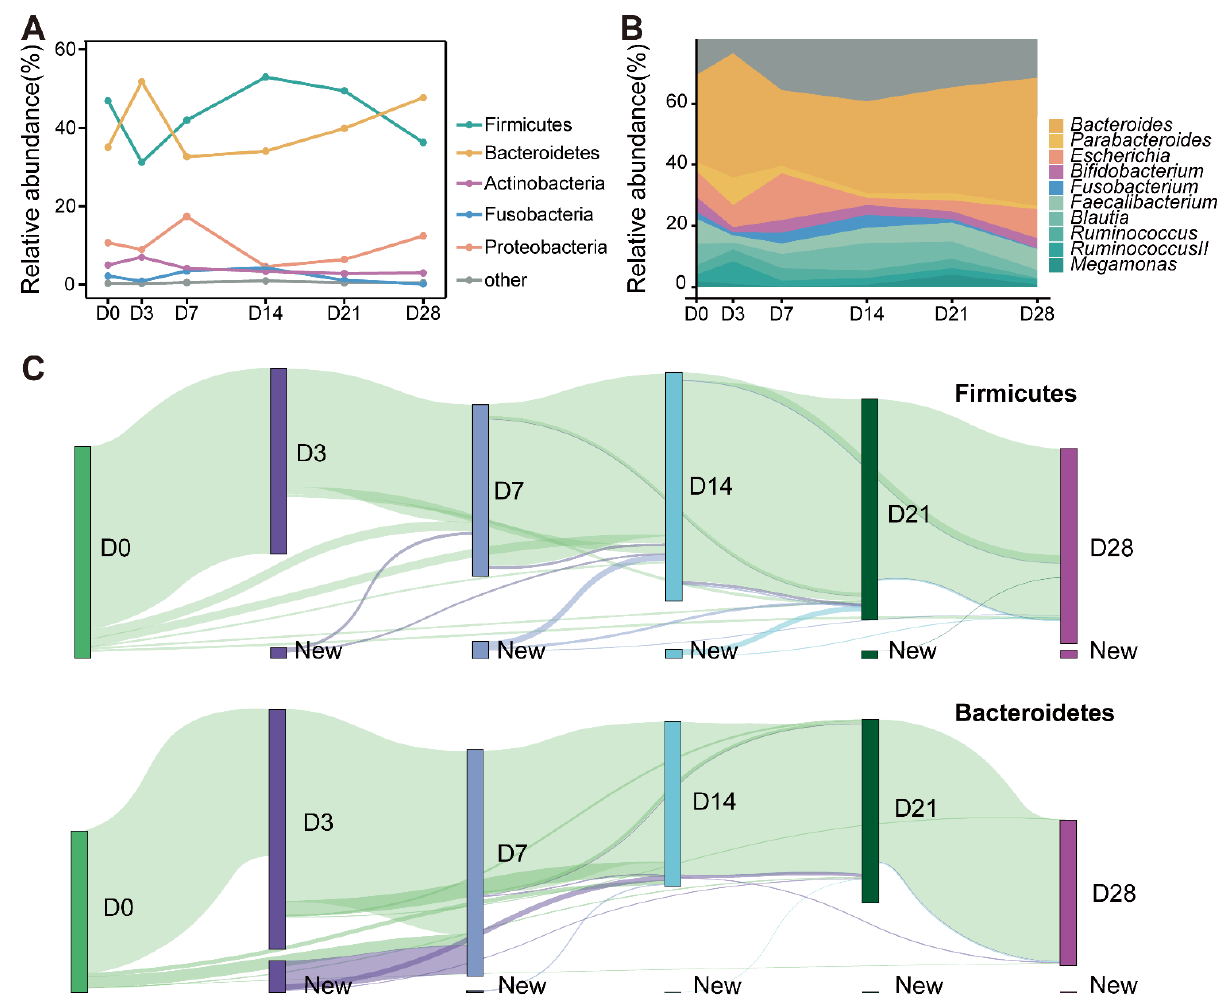
Figure 4. Dynamic changes in microbiota after bowel preparation at different levels. ( A ) Changes in different intestinal microbiota over time at the phylum level. ( B ) The area map shows the trend of the relative abundance of different bacterial groups at the genus level. The figure shows the 10 genera with the highest relative abundance, where the genera represented by similar colors correspond to the phyla in Figure 3A. ( C ) ASVs are tracked using Sankey plots in both Firmicutes and Bacteroidetes over time. The heights of the rectangle indicate the relative number of ASVs. The lines represent the transition of ASVs between different time points and are colored according to the time point of first appearance.